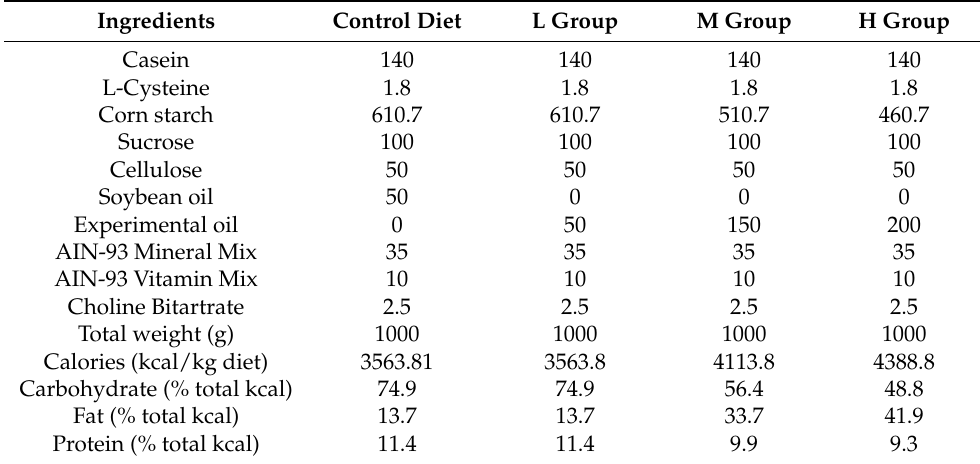
Table 2. Composition of the experimental diets (g/kg